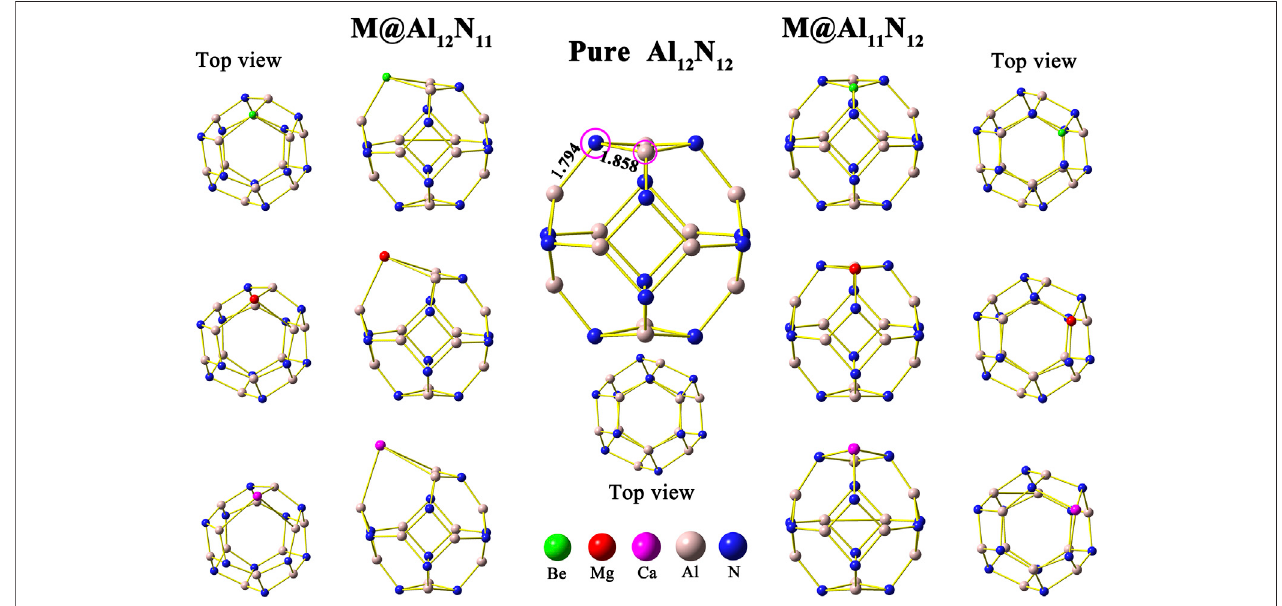
FIGURE 1 | Optimized geometric structure of undoped Al 12 N 12 and alkaline-earth metal-doped M@Al 12 N 11 and M@Al 11 N 12 (M = Be, Mg, and Ca).